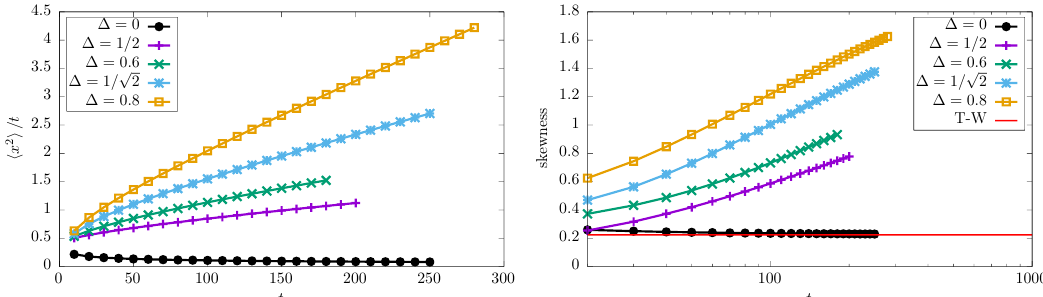
Figure 10: Left: variance divided by t , as a function of time t . As can be seen, the distribution is much more delocalized than expected from regular diffusion. The free fermion point is also shown for comparison, in that case we expect a decay as t − 1 / 3 . Right: skewness as a function of time (on a logarithmic scale). It appears to grow slowly with time, possibly logarithmically. The skewness of T-W, which is much smaller, is also shown for comparison, and matches very well the free fermion